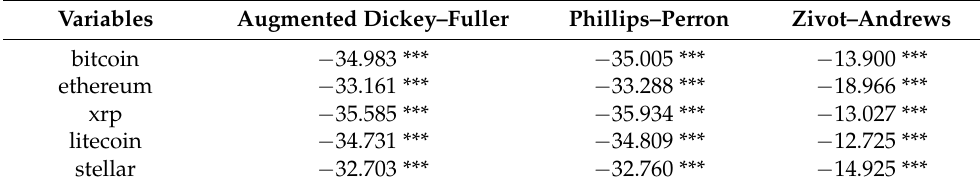
Table 3. Test of stationary.